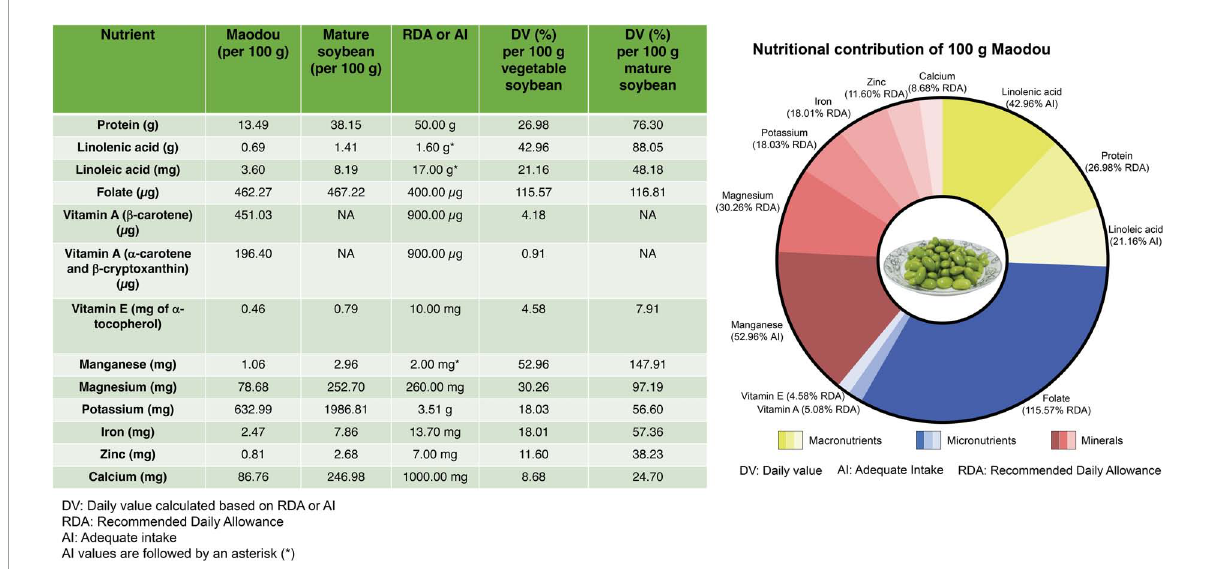
FIGURE8 The average nutritional composition of maodou in this study and the corresponding daily values according to the recommended daily allowance (RDA) or adequate intake